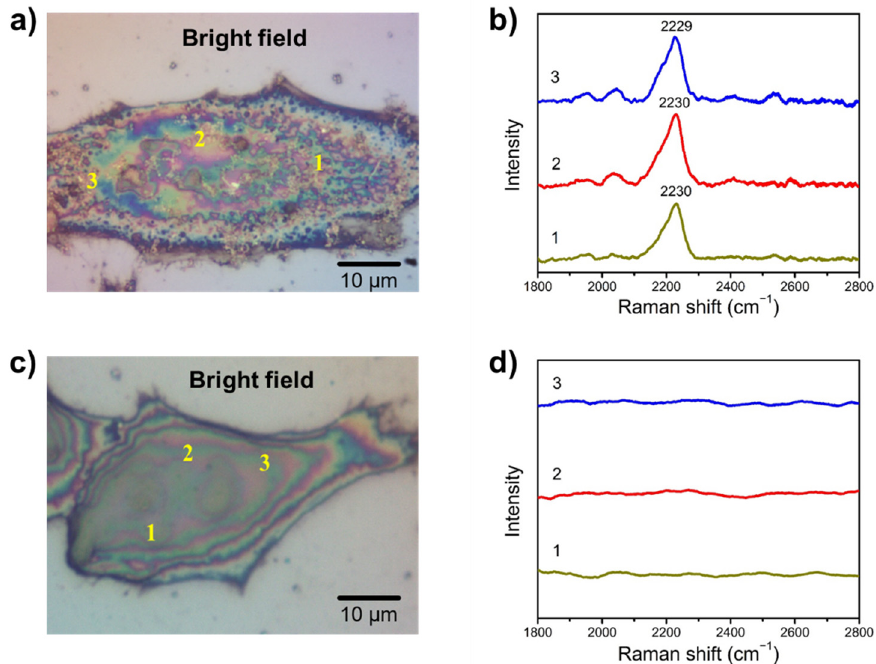
Figure 3 . Bright-field image with a location marker for corresponding SERS spectra of SA on the HeLa cell surface using the 6 -conjugated ( a , b ) and the bare AgNCs ( c , d ). λ = 532 nm, 0.78 mW, 100× objective lens, exposure time of 5 s.